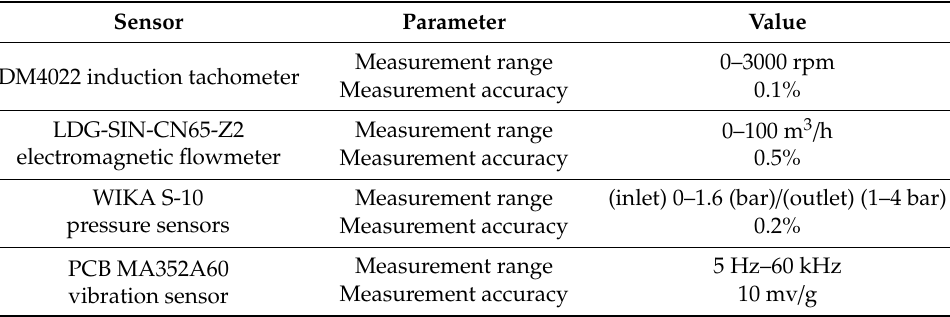
Table 2. Main parameters of the